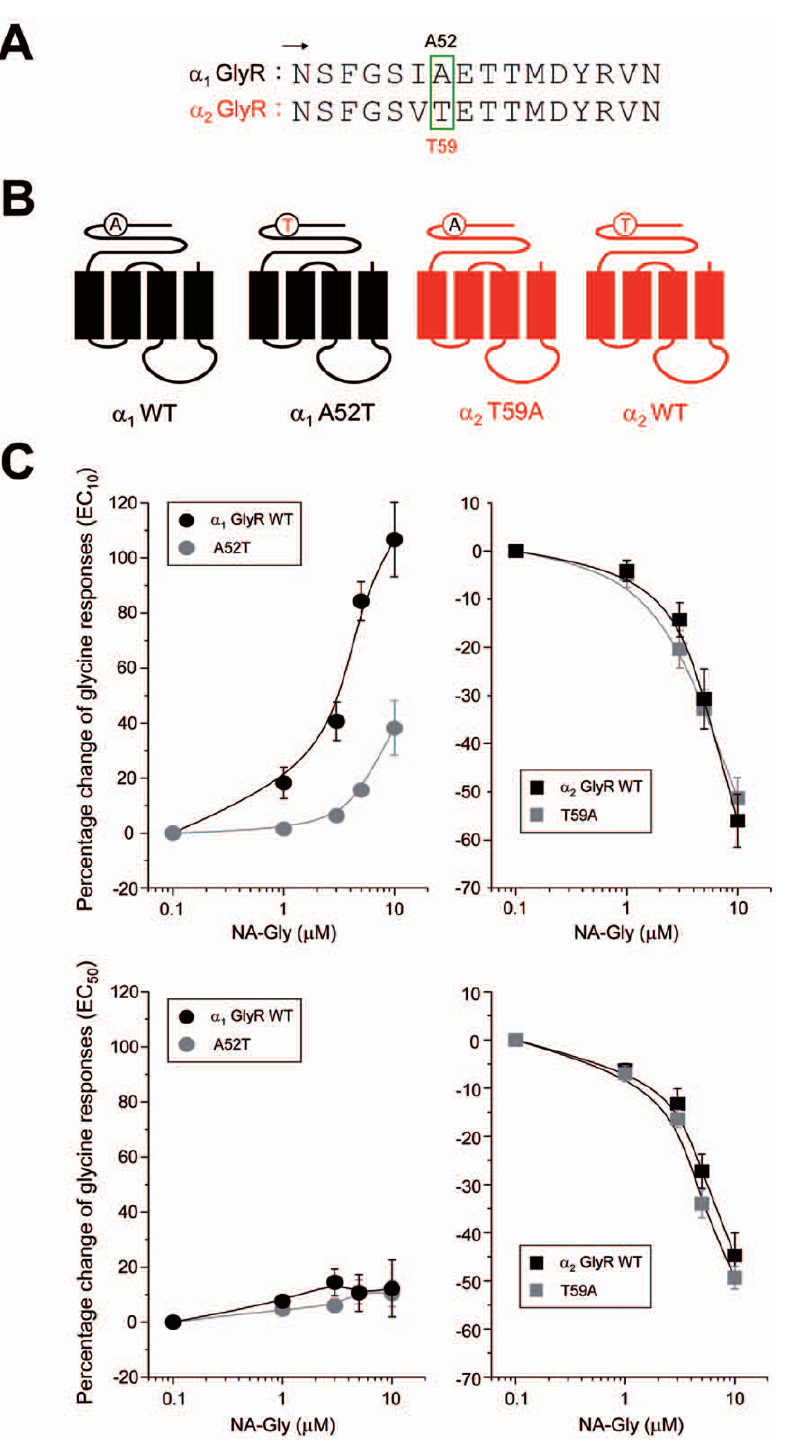
Figure 4. The composition of extracellular loop 2 influences the NA-Gly-induced potentiation of a 1 GlyRs. ( A ) Amino acid sequence alignment between a 1 and a 2 GlyRs within the extracellular loop 2. The A52 residue in a 1 GlyRs and their homologous position in a 2 GlyRs are highlighted by a green box. ( B ) Schematic depictions of GlyRs with point mutations in the extracellular loop 2 ( C ) Concentration-response curves for NA-Gly in wild-type and extracellular loop 2-mutated a 1 and a 2 GlyRs using two different agonist concentrations. The mutation A52T significantly attenuated the NA-Gly sensitivity of a 1 GlyRs, whereas the reverse mutation in a 2 GlyRs (T59A) did not alter NAGly-induced inhibition. doi:10.1371/journal.pone.0023886.g004 phytocannabinoids (e.g. D 9 -tetrahydrocannabinol (THC) or can- mechanisms or by affecting their binding is still a matter of debate. nabinodiol) on GlyRs [10,28–29]. Whether these molecular sites Mutations to the S267 residue in a 1 GlyRs affect the actions of several other allosteric modulators probably by altering their affect the cannabinoids actions by interfering with allosteric